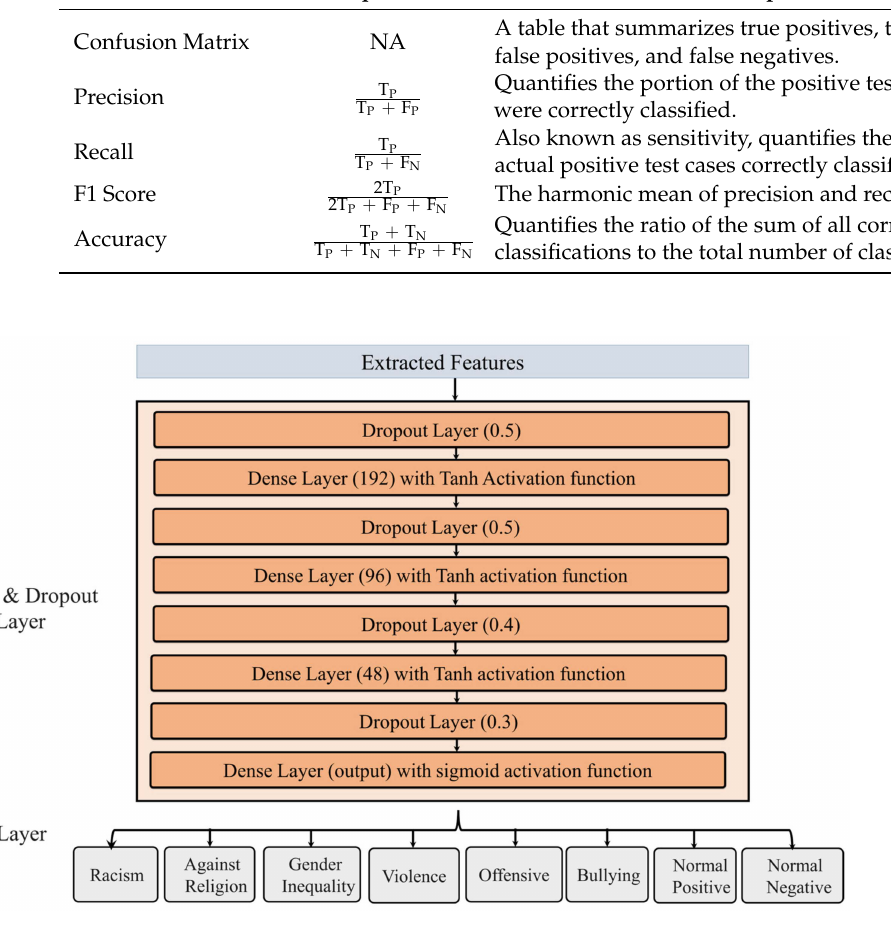
Figure 4. Architecture of the convolutional operations for the hate speech detection from the extracted